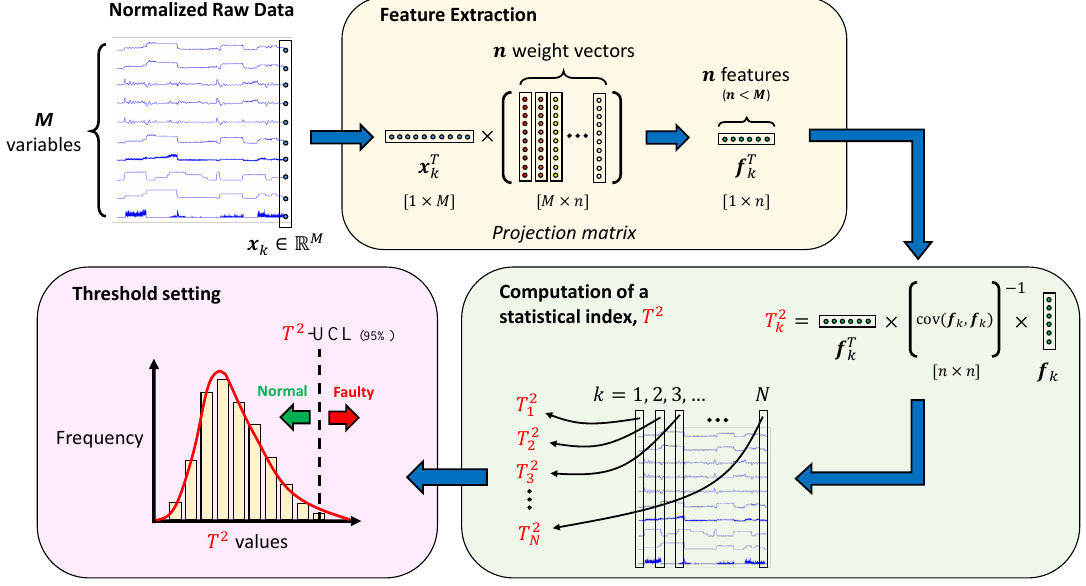
Figure 2. Basic steps of typical Multivariate Statistical Process Monitoring (MSPM) methods to achieve fault detection. Here, the feature extraction step shows only a linear transformation of